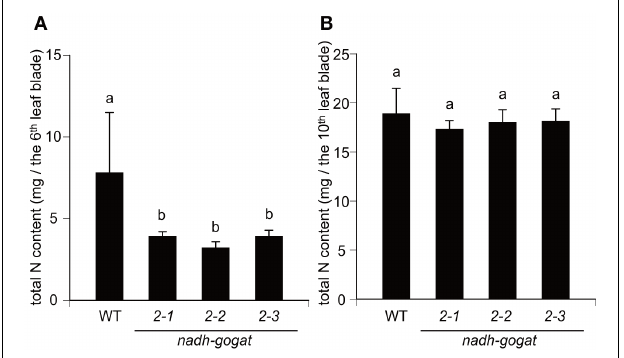
FIGURE 5 |Total nitrogen contents in the 6th and 10th leaf blade of the OsNADH-GOGAT 2 mutants hydroponically grown for 55days. Under these growth conditions, the 10th leaf blade was just fully expanded in all line of the mutants andWT. (A) Nitrogen contents in sixth leaves. (B) Nitrogen contents in 10th leaves. Means of five independent samples and SD are indicated. Different letters indicate significant differences ( P < 0.05) in Holm–Sidak corrected post hoc tests following an ANOVA.